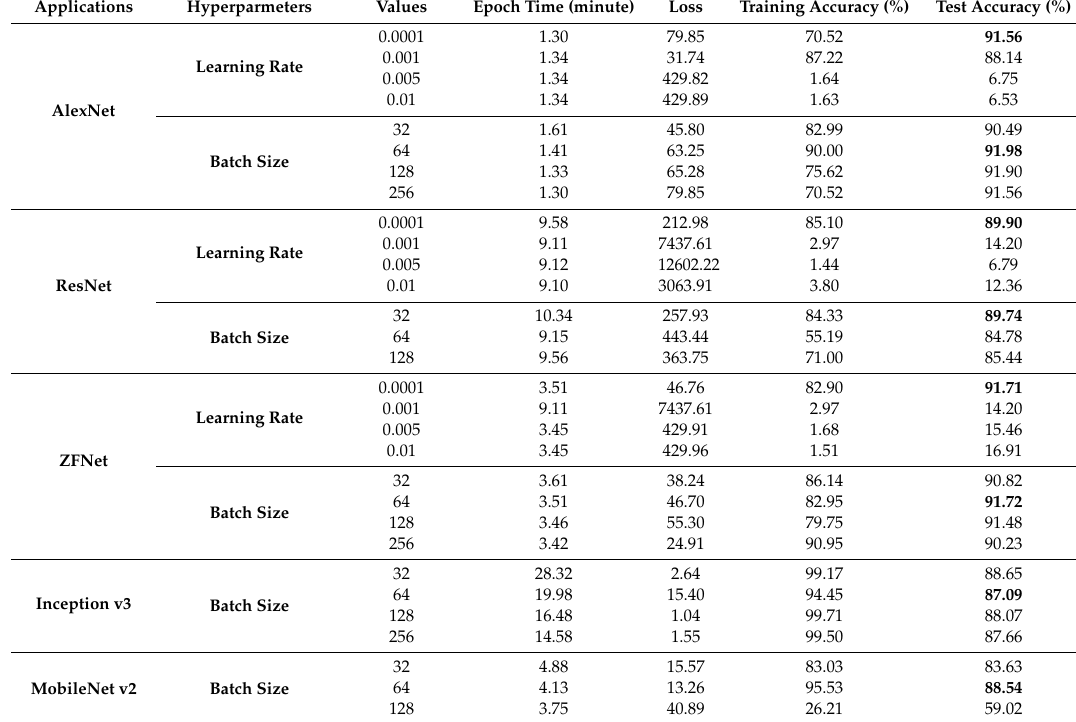
Table 5. Hyperparameter setting for CNN